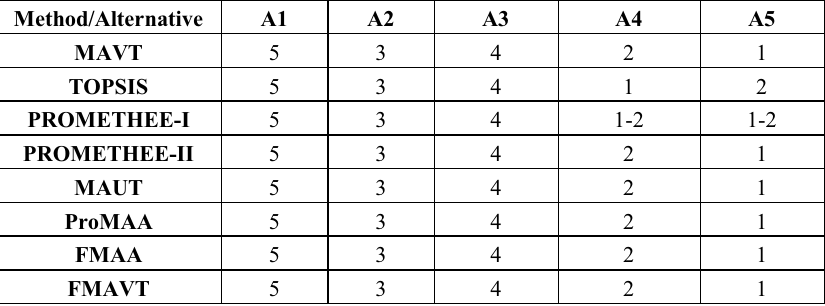
Table 3. Ranks of alternatives A 1 -A 5 for different MCDA